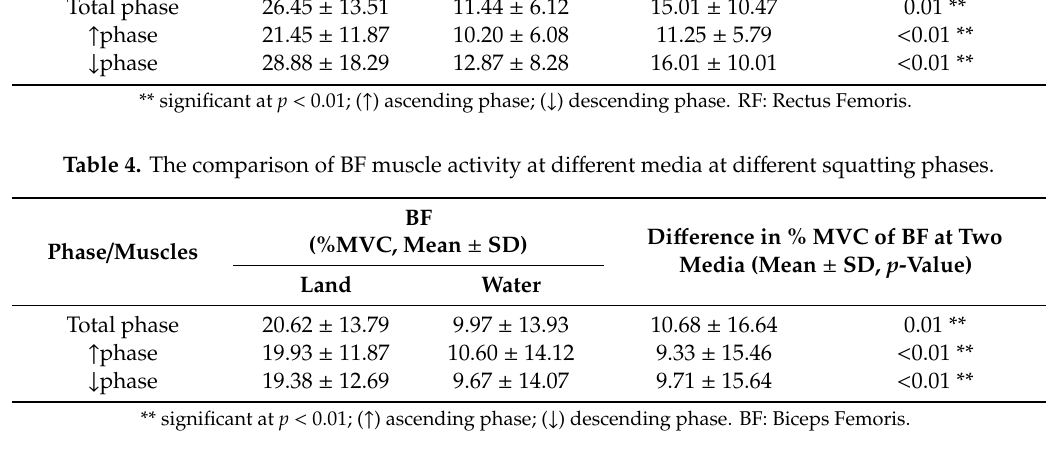
Table 3. The comparison of RF muscle activity at di ff erent media at di ff erent squatting phases. RF Phase / Muscles